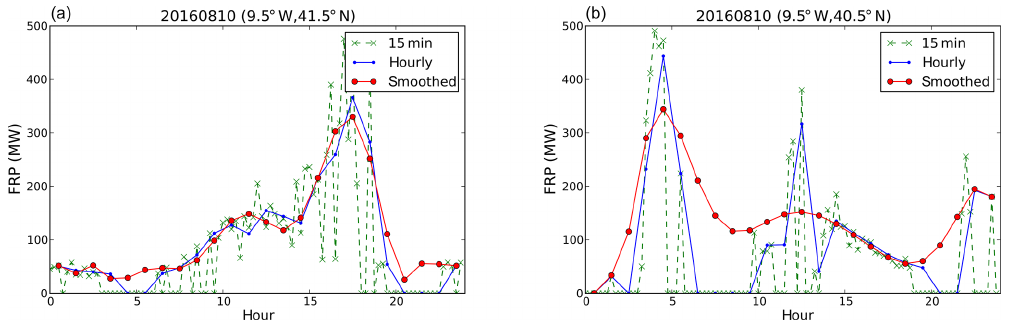
Figure 3. Example of SEVIRI FRP observations during wildfires in northern Portugal in 2016 (case study discussed in the following), averaged in 1 ◦ × 1 ◦ grid cells at 15min temporal resolution and 1h temporal resolution and smoothed using a gap filling procedure followed by a polynomial fit.